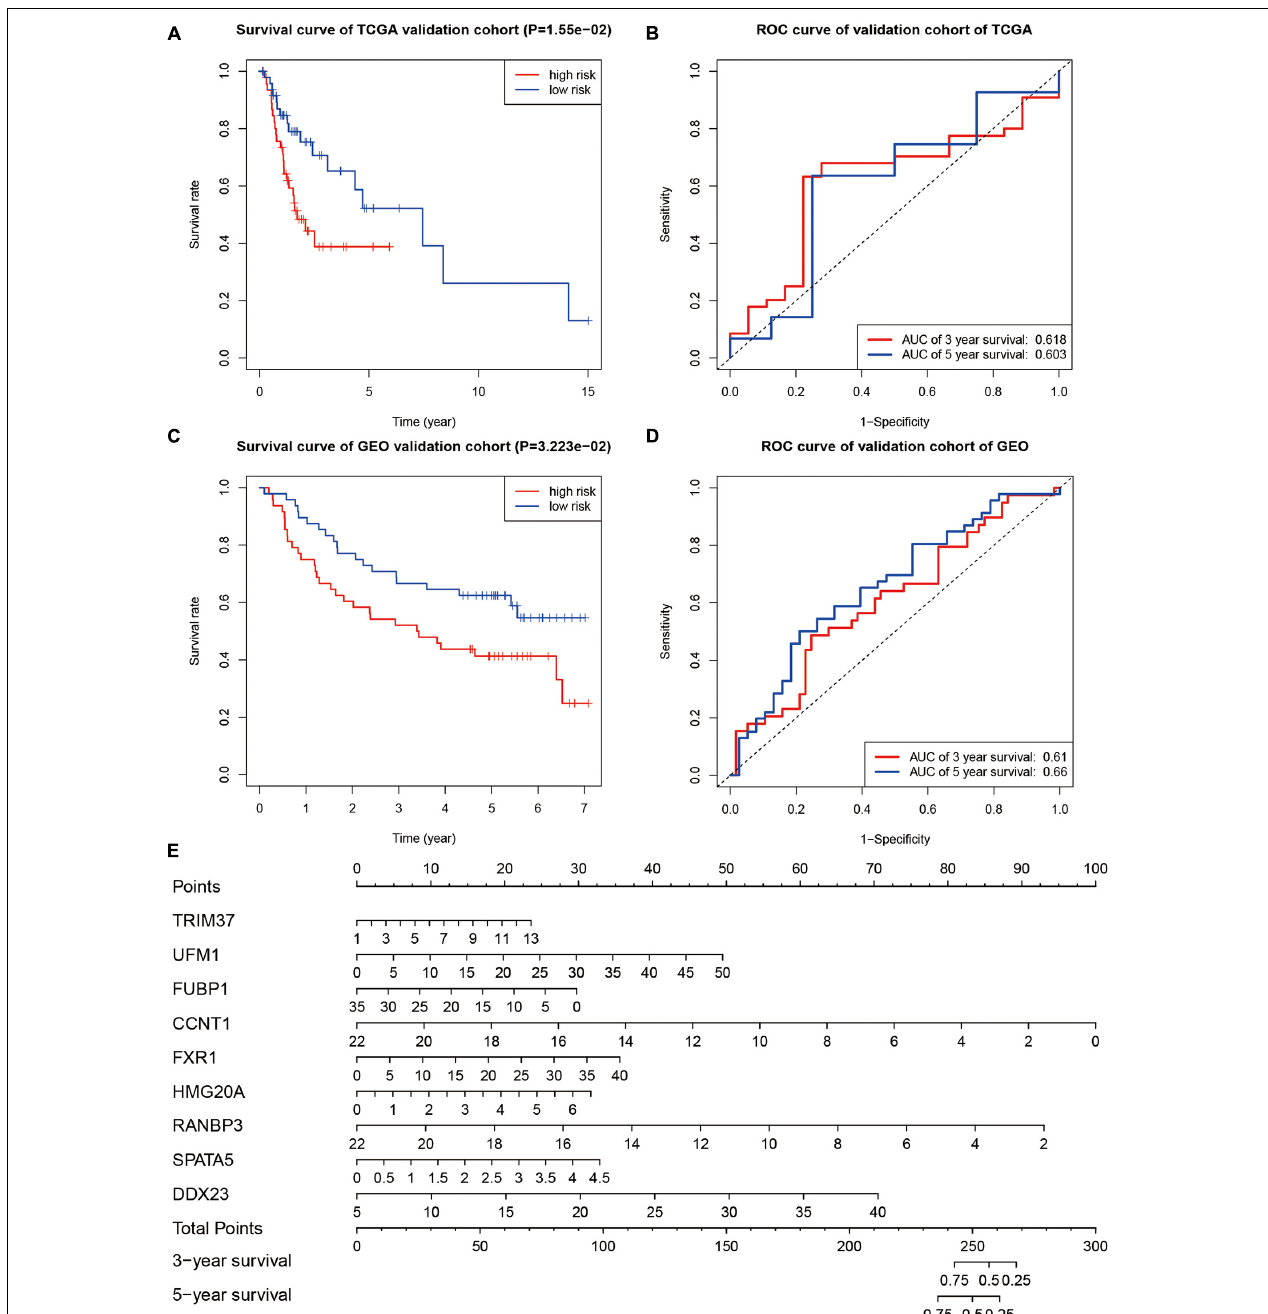
FIGURE 7 | Evaluation of the prognostic ability. (A) Kaplan–Meier curve in TCGA validation group. (B) ROC curve in TCGA validation group. (C) Kaplan–Meier survival curve in the GEO validation group. (D) The ROC curve in the GEO validation group. (E) Nomogram to predict overall survival of OSCC.